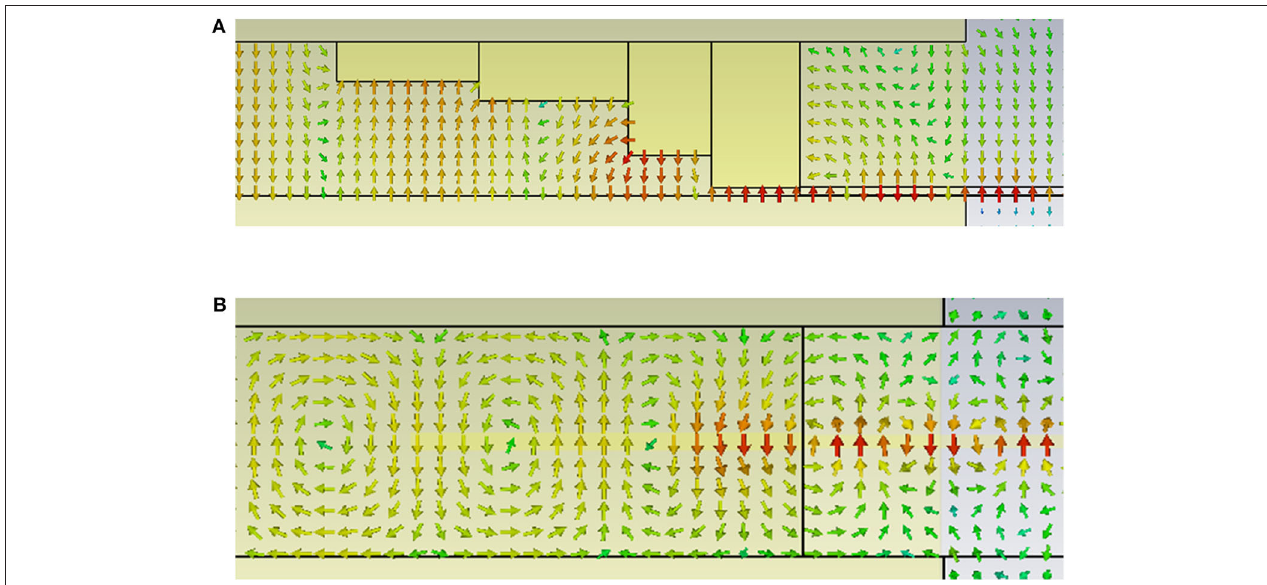
FIGURE 4 | Mode conversion from the rectangular waveguide to the microstrip line with stepped ridge. (A) (side view) Distribution of the electric field. (B) (top view) Distribution of the magnetic field.